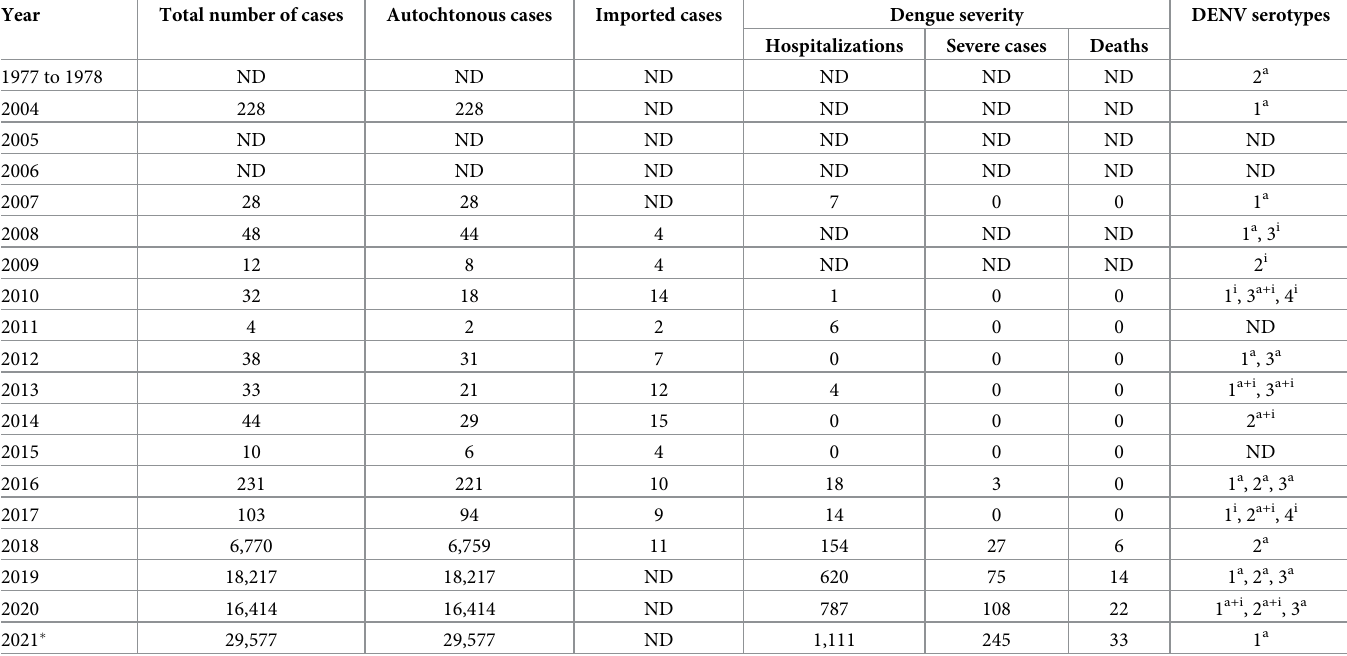
Table 1. Summary of the number of confirmed cases of dengue and severe dengue disease in Reunion from 1977 to 2021.